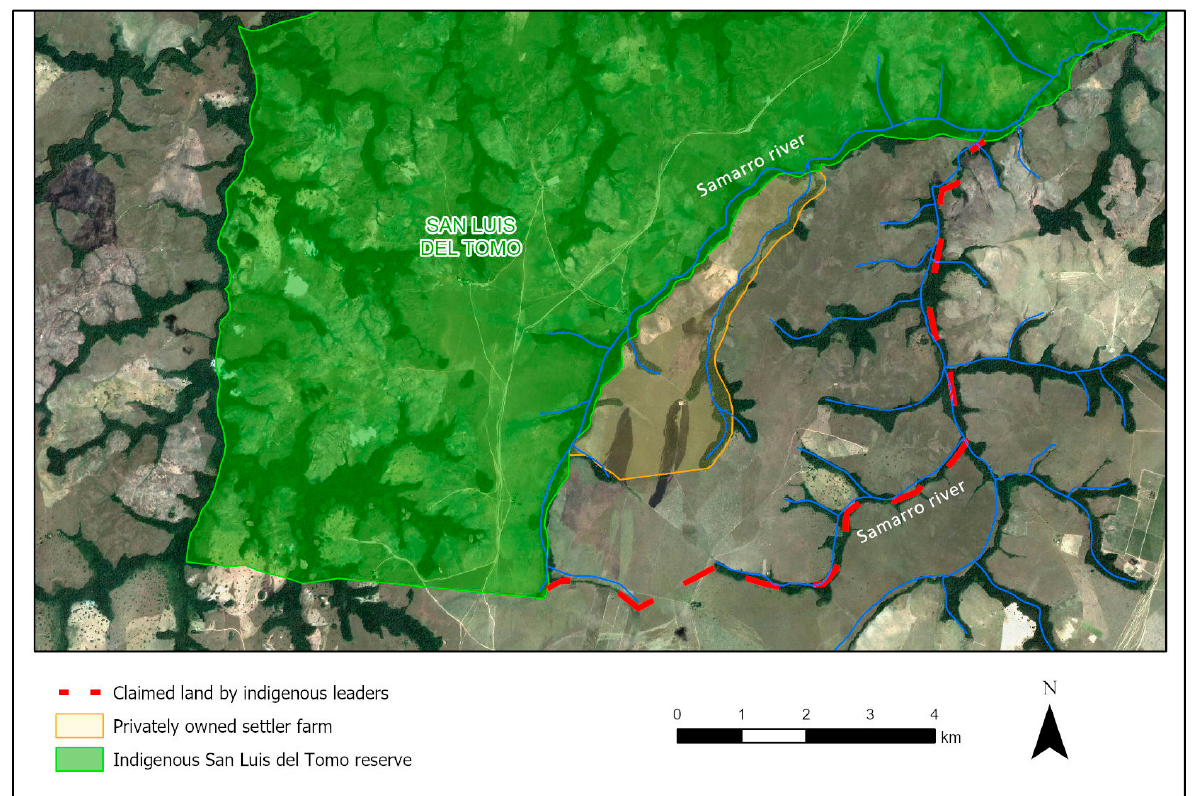
Figure 11. The Indigenous San Luis del Tomo reserve. The red line indicates the limit of the reserve according to the Indigenous peoples. Approximately 3000 ha are claimed by the Indigenous peoples. There is already one private parcel in the claimed area. Cumaribo, 2020. Source: Land in Peace Project,